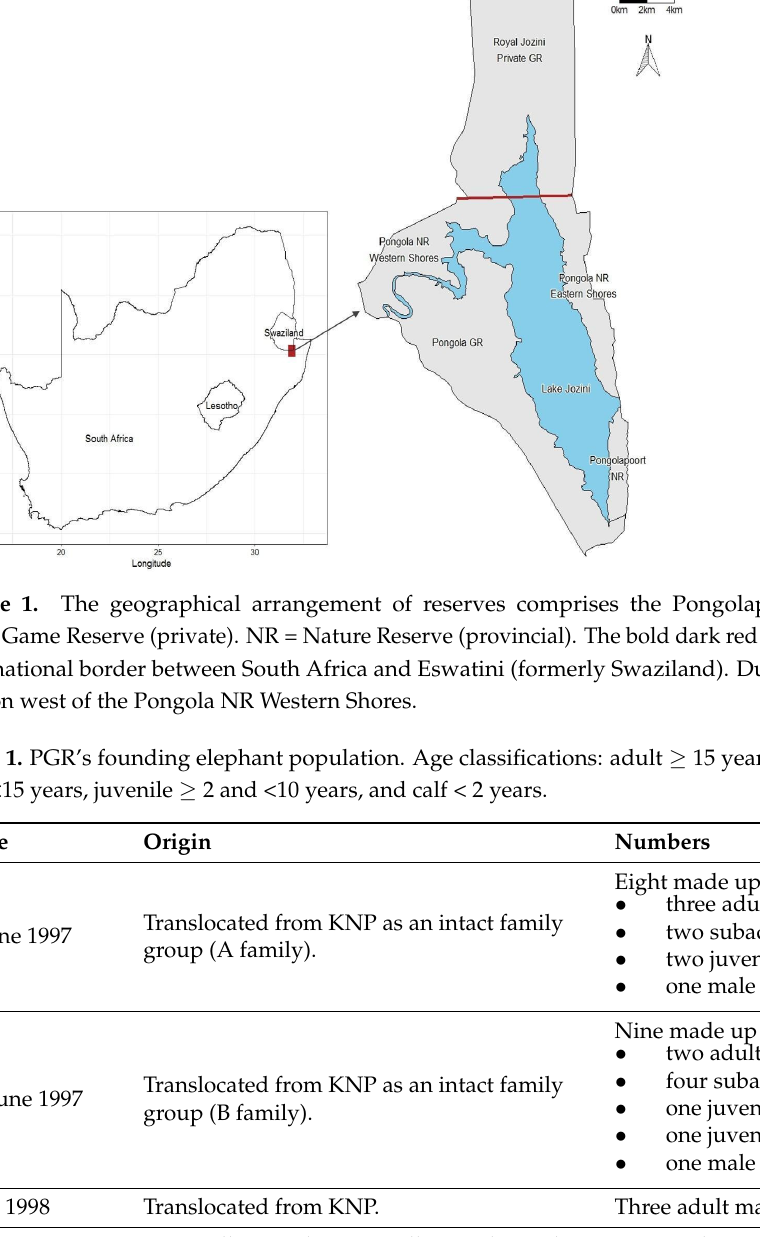
Table 1. PGR’s founding elephant population. Age classifications: adult ≥ 15 years, subadult ≥ 10 and <15 years, juvenile ≥ 2 and <10 years, and calf <2 years.